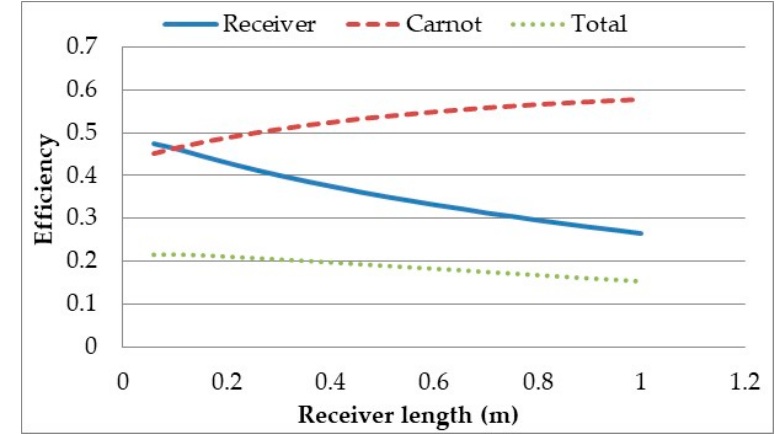
Figure 9. Overall power plant efficiency versus receiver length at high temperature: heat loss calculation was done applying Boltzmann’s law.